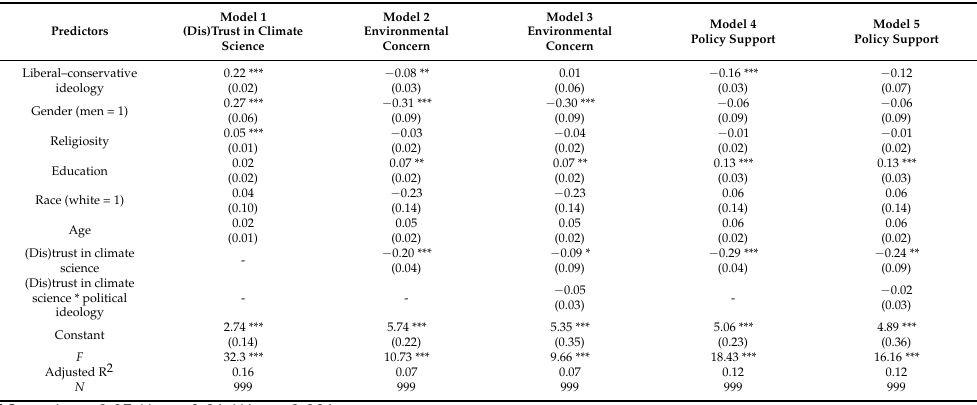
Table 4. Unstandardized coefficients from OLS regression models explaining (dis)trust in science, environmental concern, and pro-environmental policy support among skeptics (standard errors in